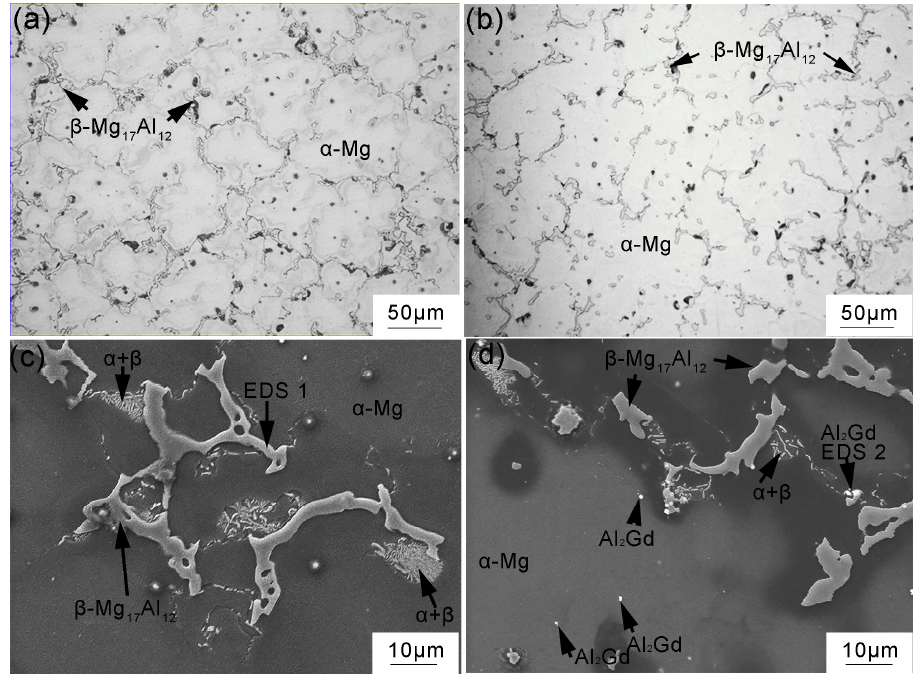
Figure 3. Microstructures of surfacing magnesium alloys: ( a , c ) AZ91 alloy, ( b , d ) AZ91 + 0.5 Gd alloy.